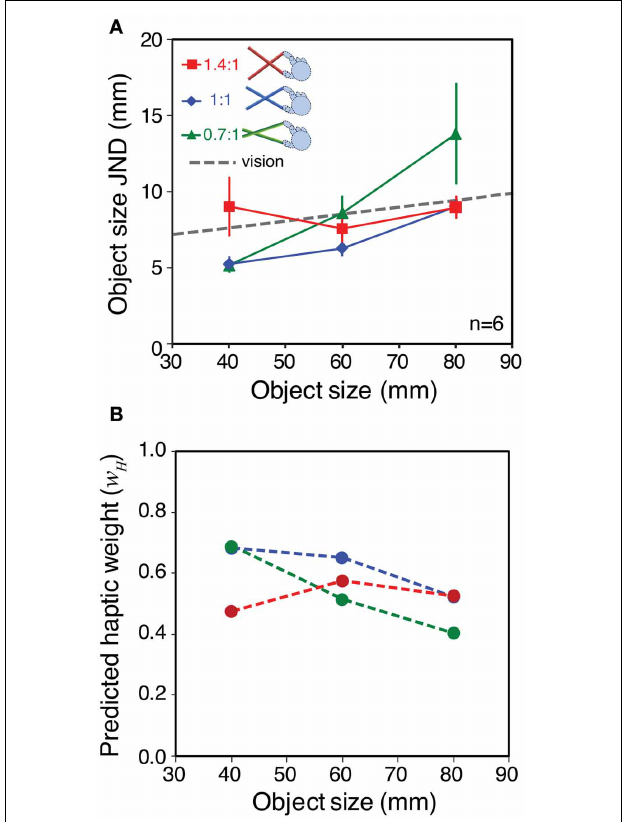
FIGURE 6 | Sensitivity to object size and predicted signal weights for Experiment 2. (A) Haptic object-size JNDs for the three different object sizes, felt with each tool type. The gray dashed line shows the estimated visual sensitivity after adjusting each participant’s visual noise level to approximately match his or her average haptic sensitivity (see main text). Error bars are ± 1 standard error. (B) Predicted haptic weights in each experimental condition, calculated using the sensitivity data from panel (A) , where w V = 1 − w